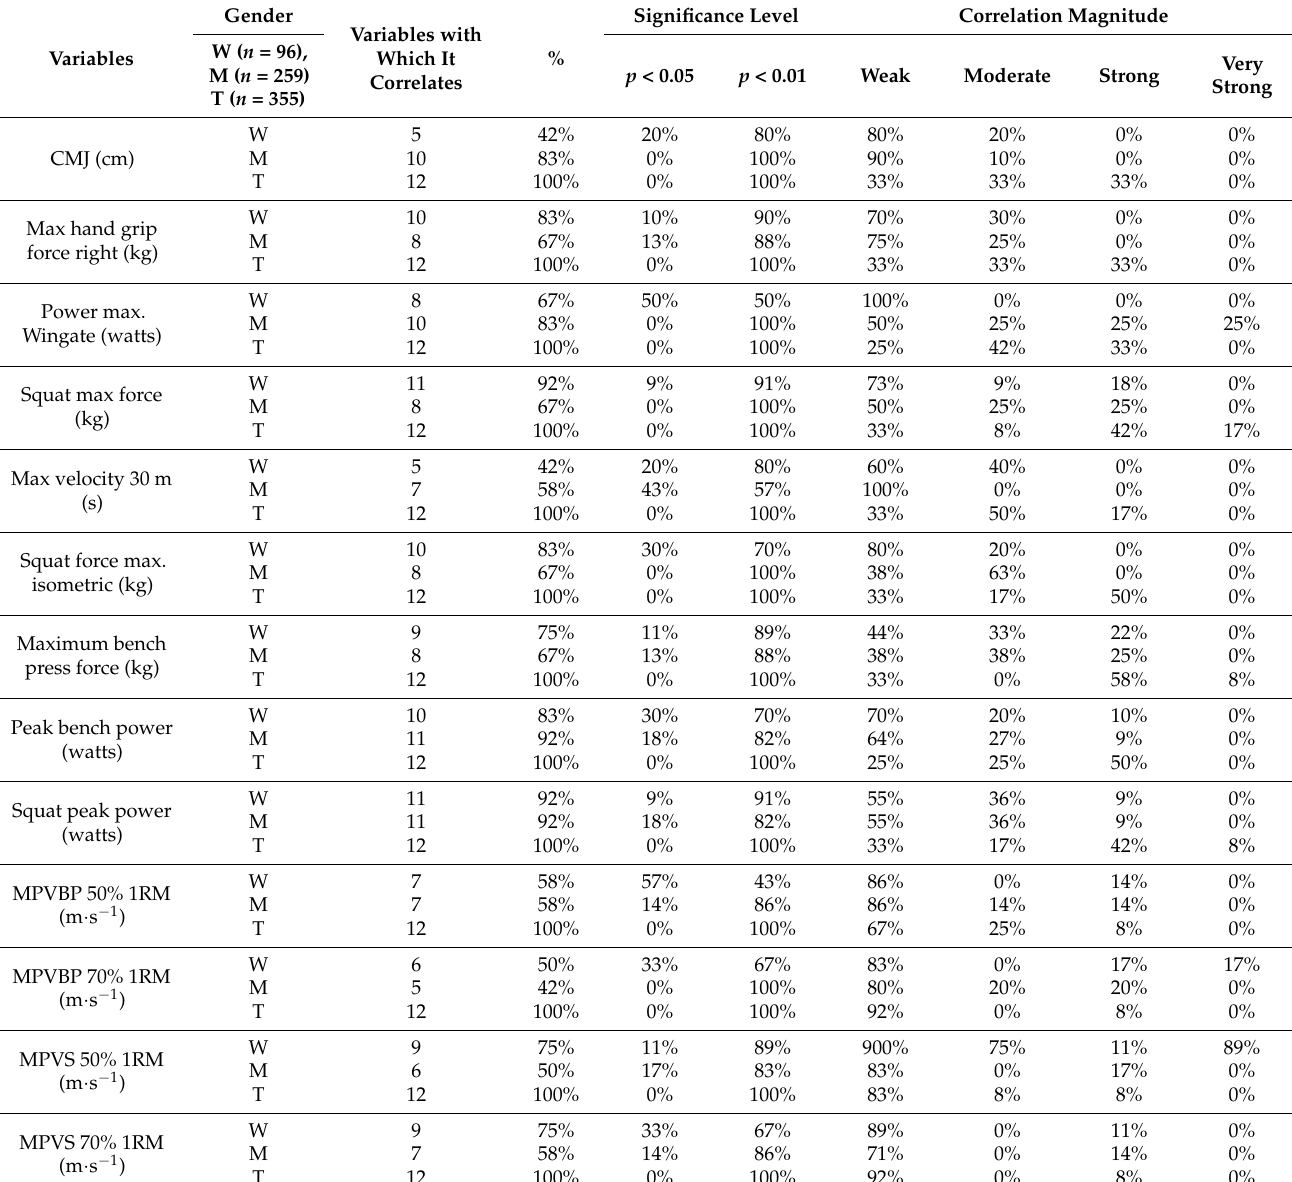
Table 2. Quantity, significance level, and magnitude of the correlations between the different strength